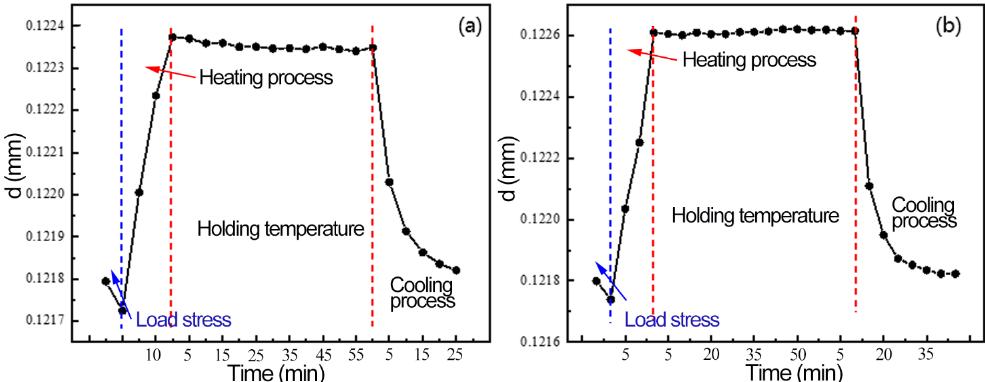
Figure 11. Variation of crystal plane spacing under multiple fields: ( a ) 200 °C, ( b ) 280 °C.